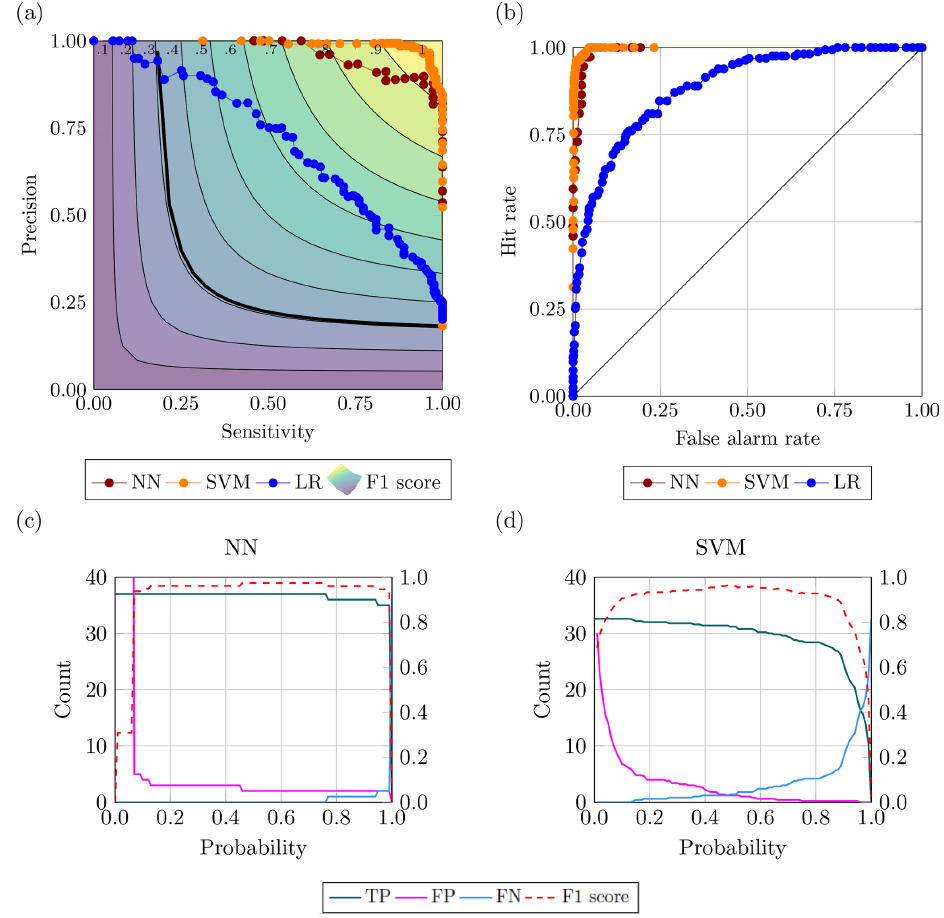
Figure 14. Best-performing configurations for the drought case: (a) PS curve; (b) ROC curve; and variation of true positive, false positive, true negative and F1 score for the range of probability (c) in NN and (d) in